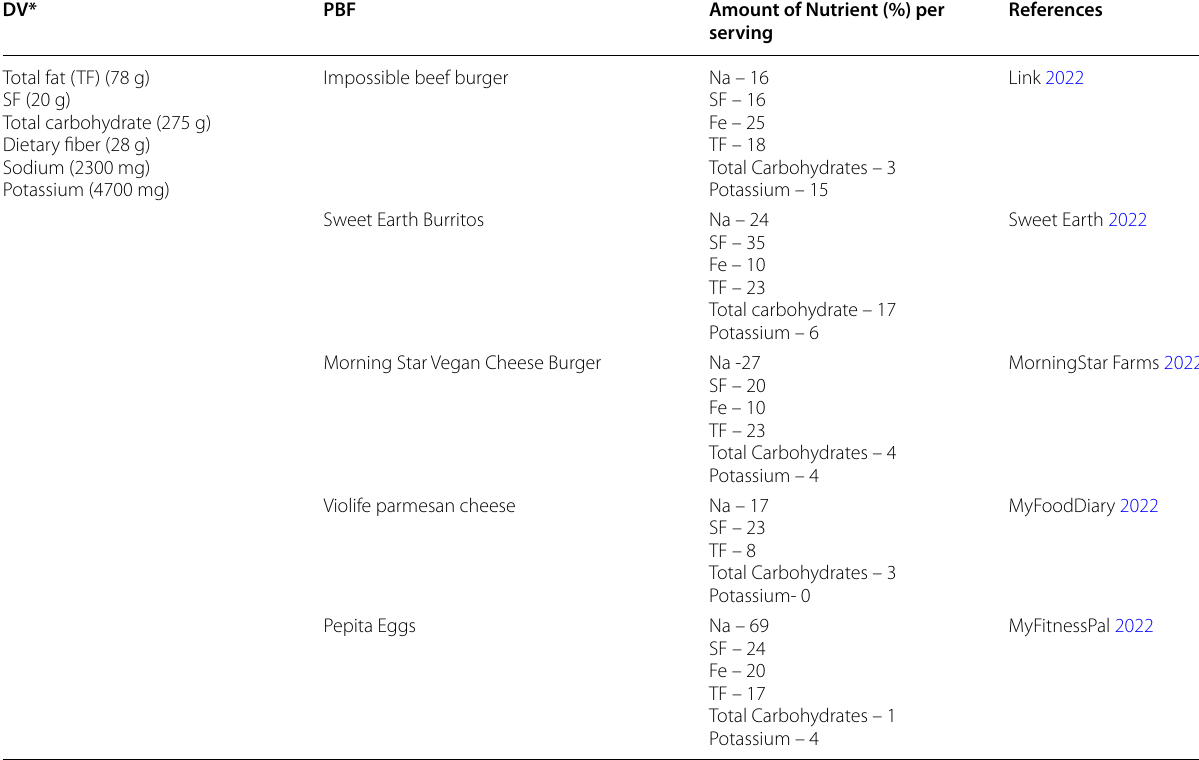
Based on a 2000-cal daily diet